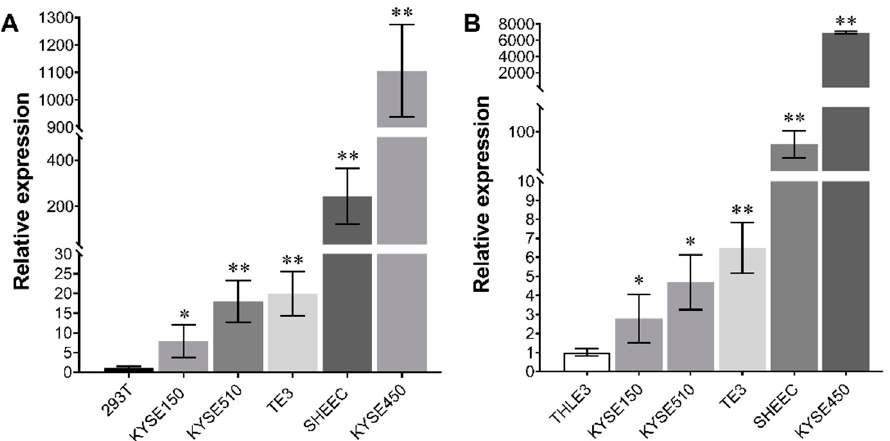
Figure 2. Gene expressions of BIRC3 in human esophageal cancer cells. Cell lines 293T cells and THLE3 served as controls, respectively. Bars indicate mean ± SD. * and ** shows significant difference between groups p < 0.05 and p < 0.01, analyzed according to one-way ANOVA, respectively. Gene relative expressions of BIRC3 in ESCA compared with the control cells 293T ( A ) and THLE3 ( B ).